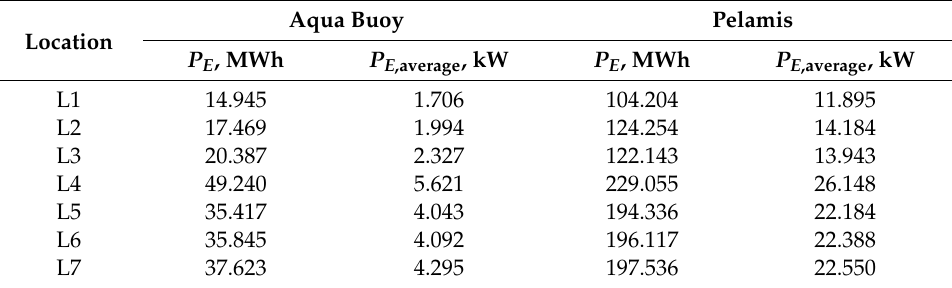
Table 3. The mean yearly wave